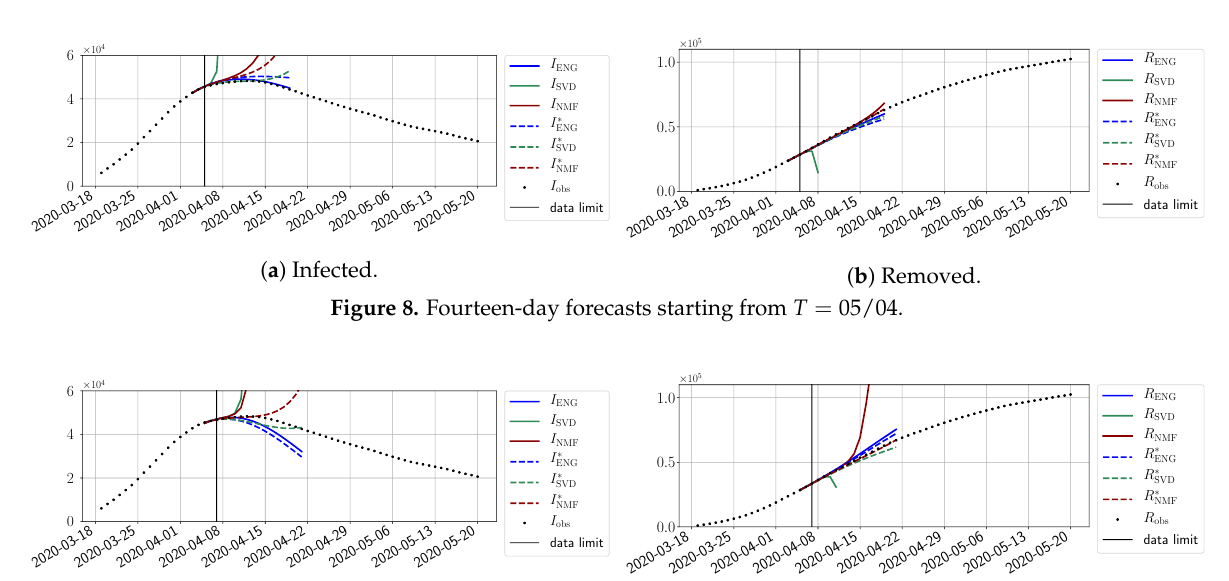
Figure 7. Fourteen-day forecasts starting from T = 03/04.